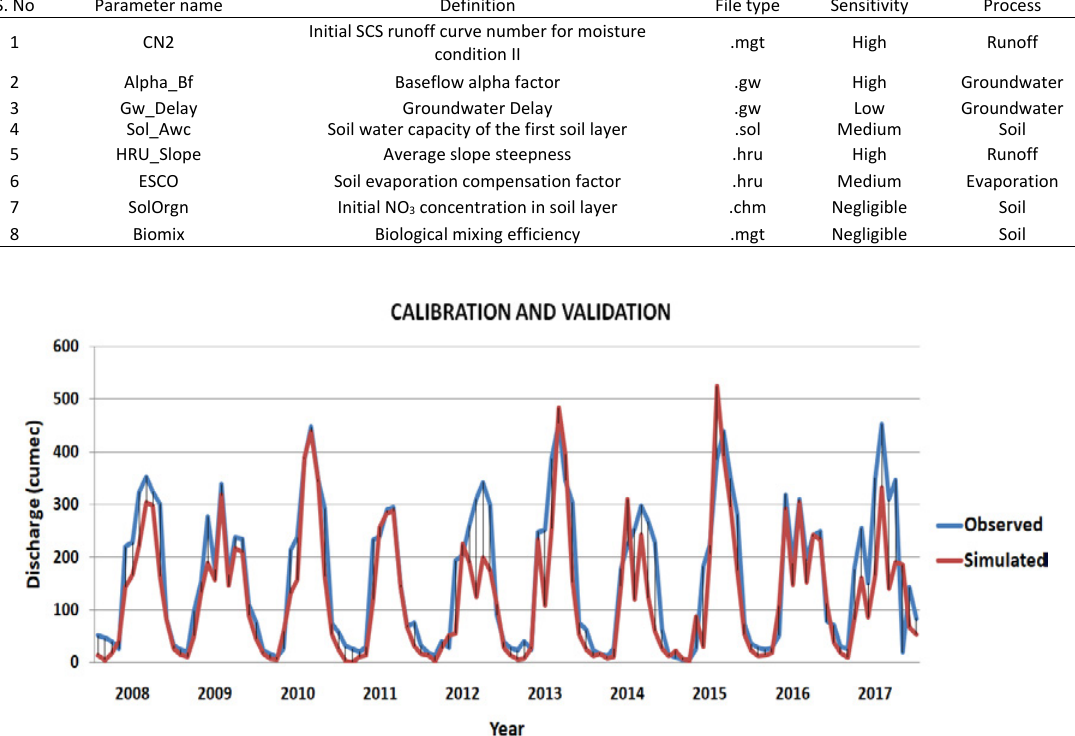
Fig.4: Calibration and validation result of SWAT model of Manipur River basin at Ithai (2008-2017)